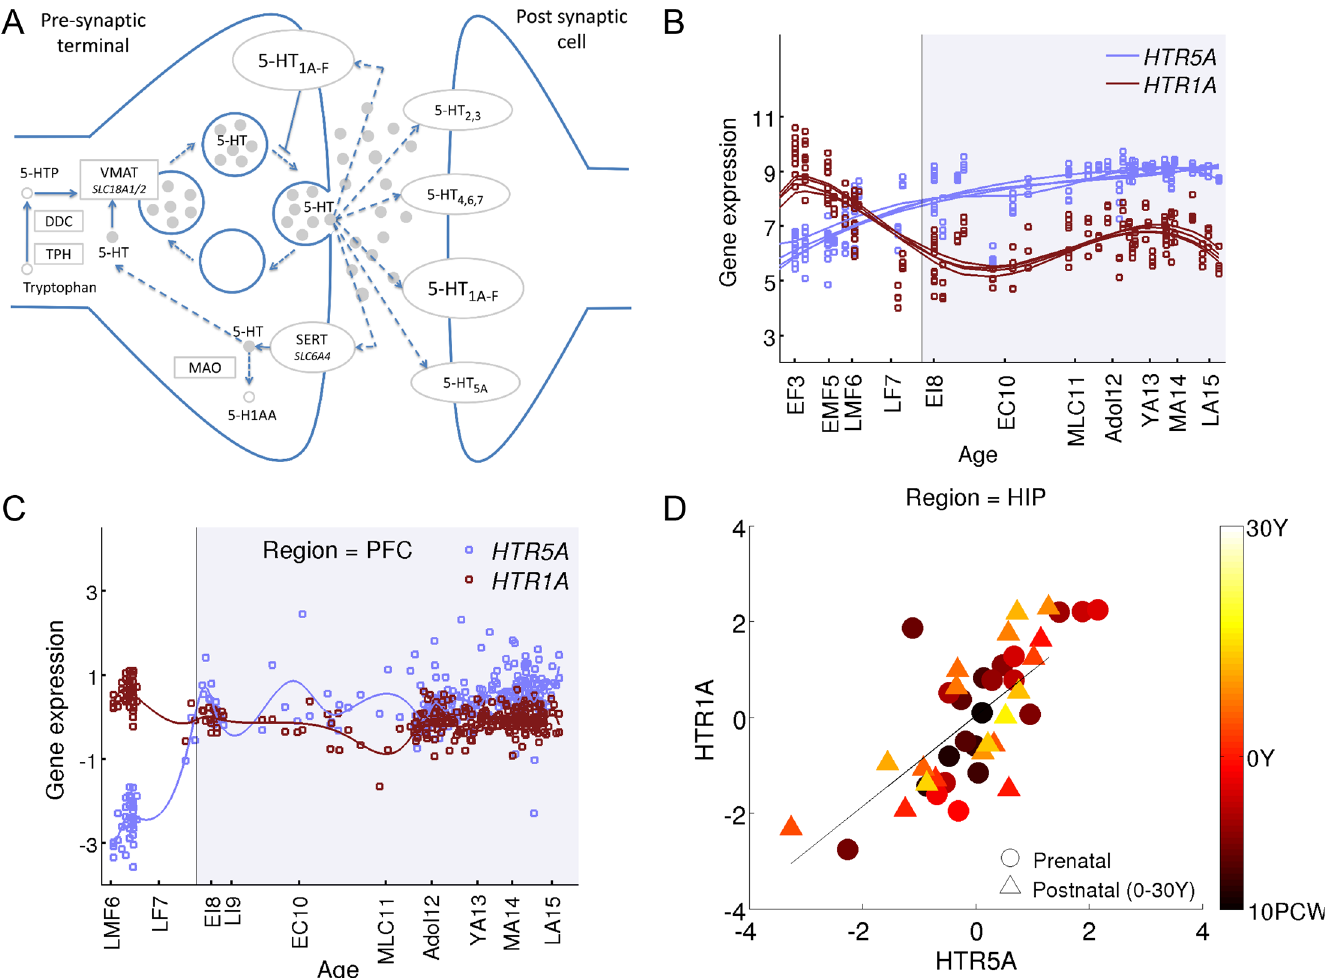
Fig 5. A novel CDV pair of serotonin-receptor genes HTR1A and HTR5A . (A) A diagram of the serotonergic synapse. (B) The gene expression profiles of HTR1A and HTR5A serotonin receptors as measured by [32] in four regions of the human prefrontal cortex: dorsolateral, medial, orbital and ventrolateral prefrontal cortex. (C) The gene expression profiles of HTR1A and HTR5A serotonin receptors as measured by [33] in the prefrontal cortex. (D) Subject to subject correlation, after removing the population effect of age, between the expression levels of HTR1A and HTR5A within two age groups, prenatal (10PCW-birth), and postnatal (0-30Y) in the